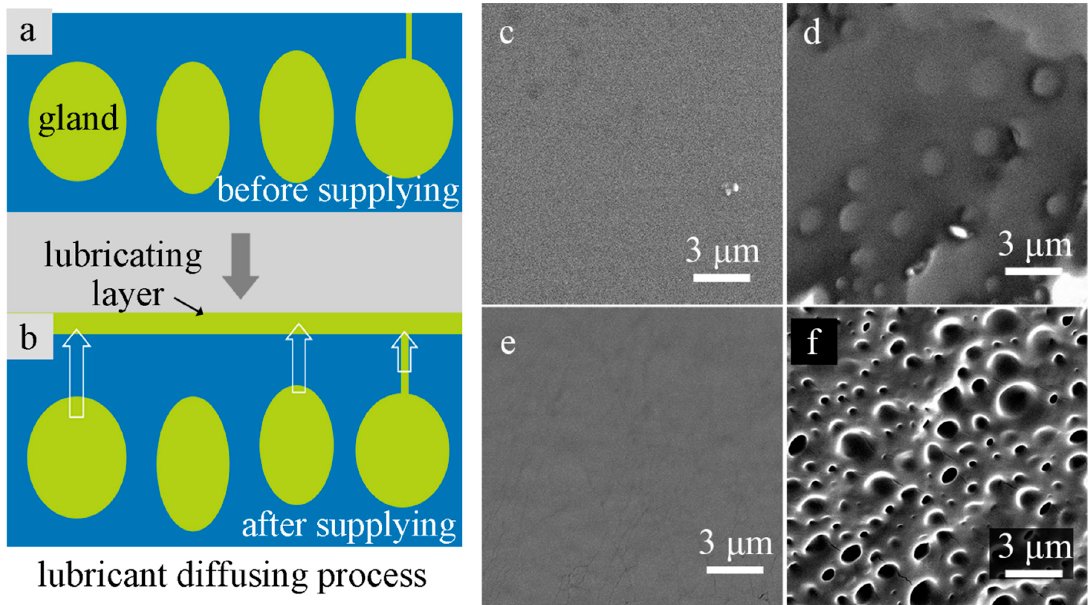
Figure 1. ( a , b ) Schematic of lubricant diffusing process. Top-view ( c ) and cross-sectional ( d ) SEM images of the 30% sample, respectively. Top-view ( e ) and cross-sectional ( f ) SEM images of the 30% sample after surfactant capsules being removed, respectively.